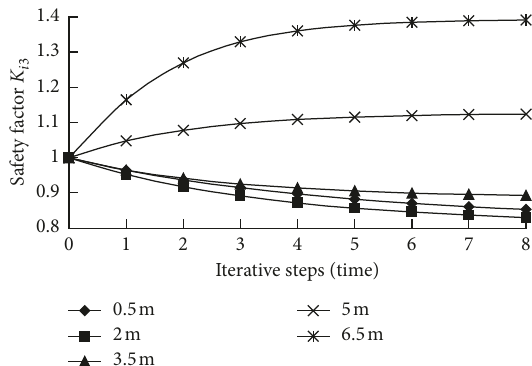
Figure 6: The iterative curve of the safety factor.